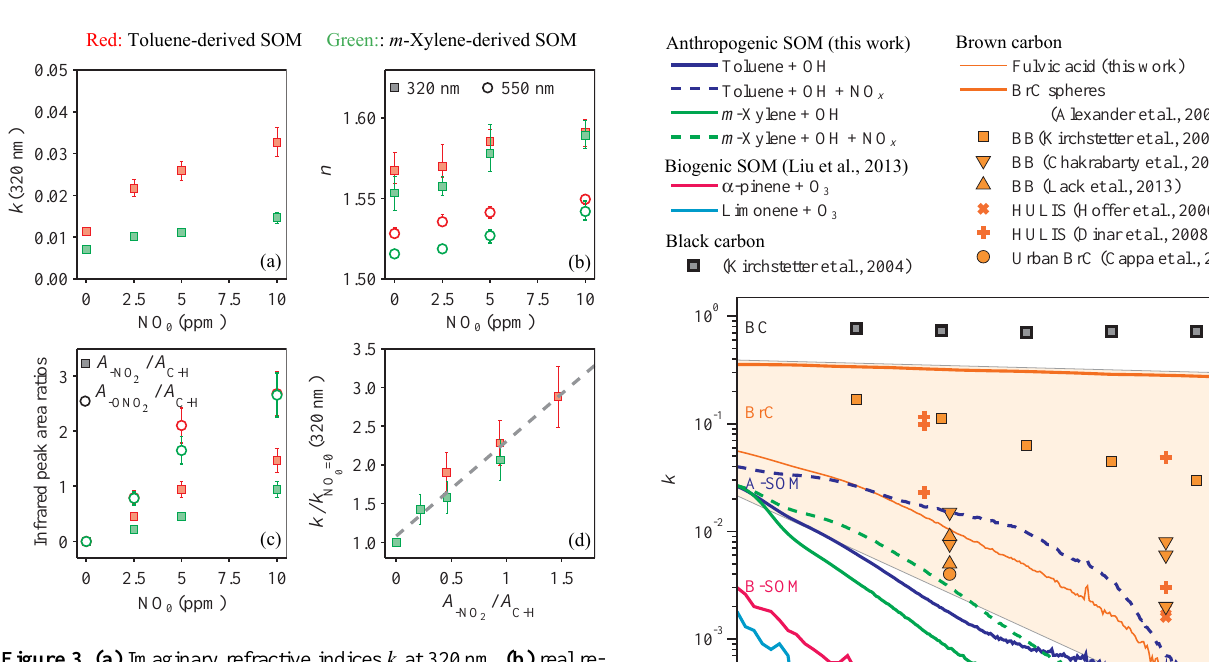
Figure 3. (a) Imaginary refractive indices k at 320nm, (b) real re- fractive indices n at 320 and 550nm, (c) the areas of nitro and ni- trate absorption bands normalized by the area of alkane bands, all as a function of initial NO concentration. Shown in (d) is the ratio of k /k NO as a function of the normalized area of nitro band 0 = 0 /A C − H ) , as drawn from (a) and (c) . See also note b for ( A − NO 2